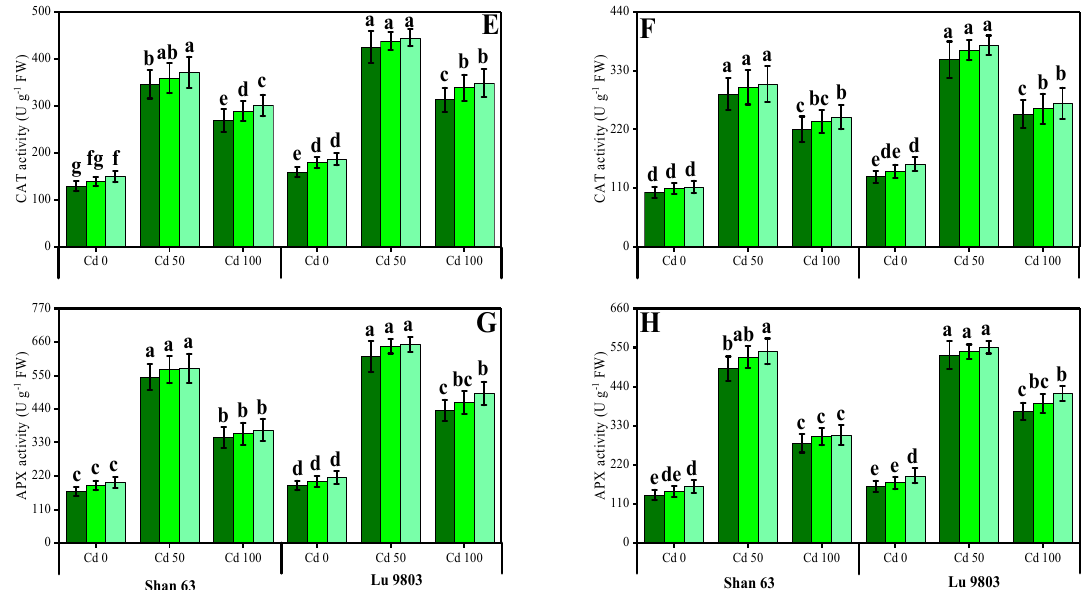
Figure 4. E ff ect of di ff erent concentrations of exogenous application of FeSO 4 (0, 50, and 100 µ M) on antioxidant activities, i.e., SOD activity in the roots ( A ), SOD activity in the leaves ( B ), POD activity in the roots ( C ), POD activity in the leaves ( D ) CAT activity in the roots ( E ), CAT activity in the leaves ( F ), APX activity in the roots ( G ) and APX activity in the leaves ( H ) of Oryza sativa (cultivars) grown under di ff erent levels of Cd stress (0, 50, and 100 µ M). Bars sharing di ff erent letter(s) for each parameter are significantly di ff erent from each other according to Duncan’s multiple range test ( p < 0.05). All the data represented are the average of four replications ( n = 4). Error bars represent the standard deviation (SD) of four replicates.